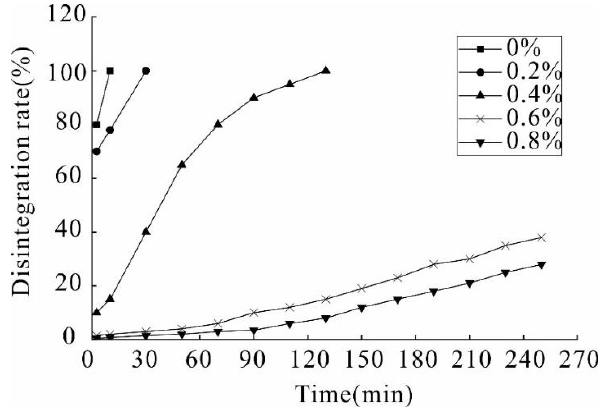
Figure 3. Variations of the disintegration resistance coefficients with different concentration.